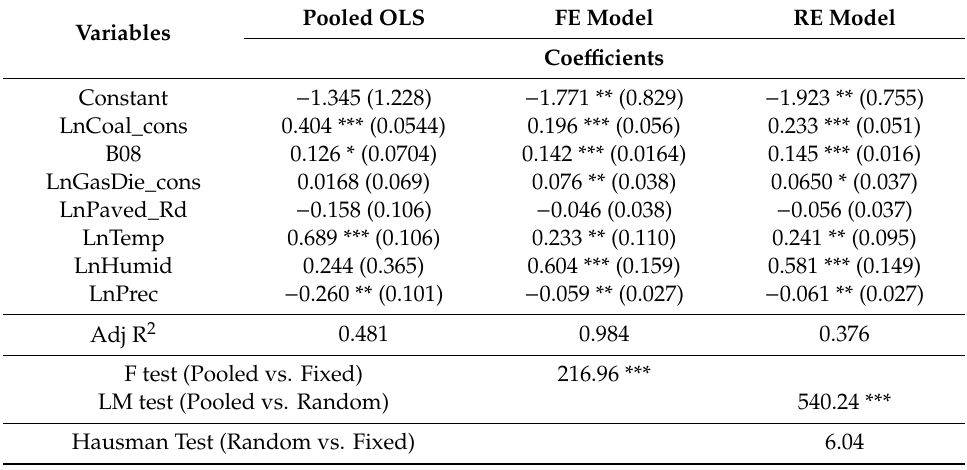
Table 3. Panel regression estimation results of impact of burning coal e ff ects on PM 2.5 .